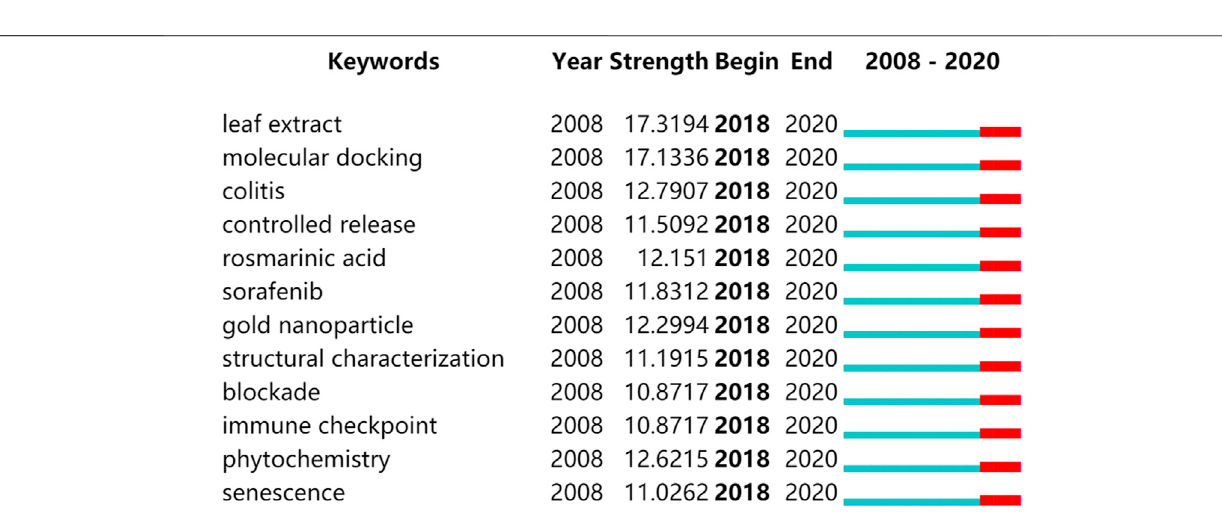
Frontiers in Pharmacology |